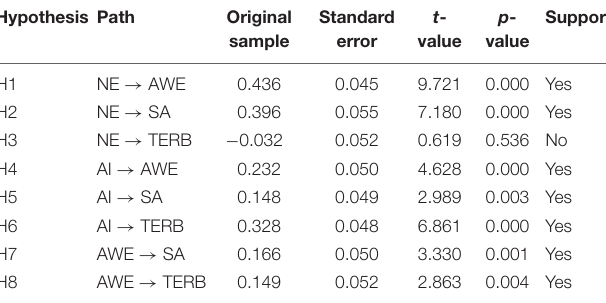
TABLE 4 | Results of the structural